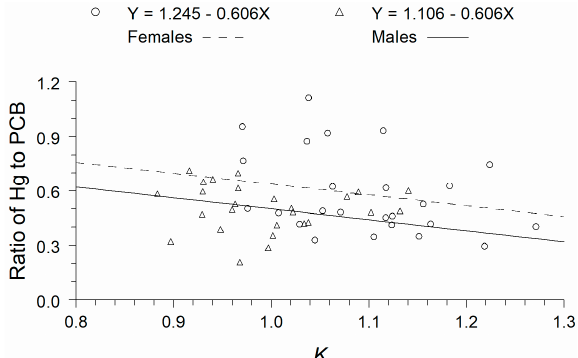
Figure 2. Ratio of whole-fish Hg concentration to whole-fish PCB concentration as a function of Fulton’s condition K of white sucker, by sex. The fitted lines were from the application of analysis of covariance (ANCOVA), with the ratio of the whole-fish Hg concentration to the whole-fish PCB concentration as the dependent variable, K as the covariate, and sex as the main effect. The sex effect in the ANCOVA was significant (ANCOVA: F = 5.14; df = 1, 48; p = 0.0280). The equality of slopes assumption for the ANCOVA was met ( F = 1.80; df = 1, 47; p = 0.1866). The white suckers were caught in April 2016 in the Kewaunee River (Wisconsin, USA), a tributary to Lake Michigan.